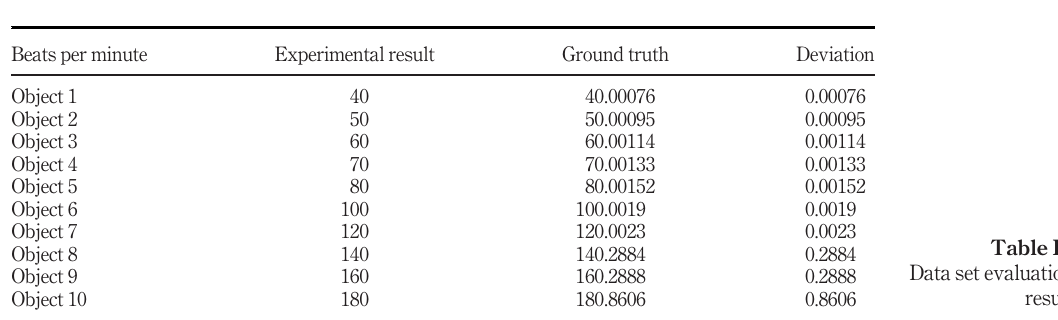
Figure 10. Output result and ground truth comparison